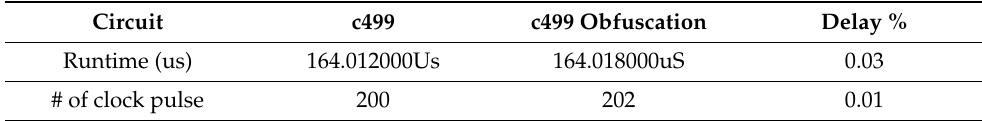
Table 3. Delay in the proposed method (SILL).